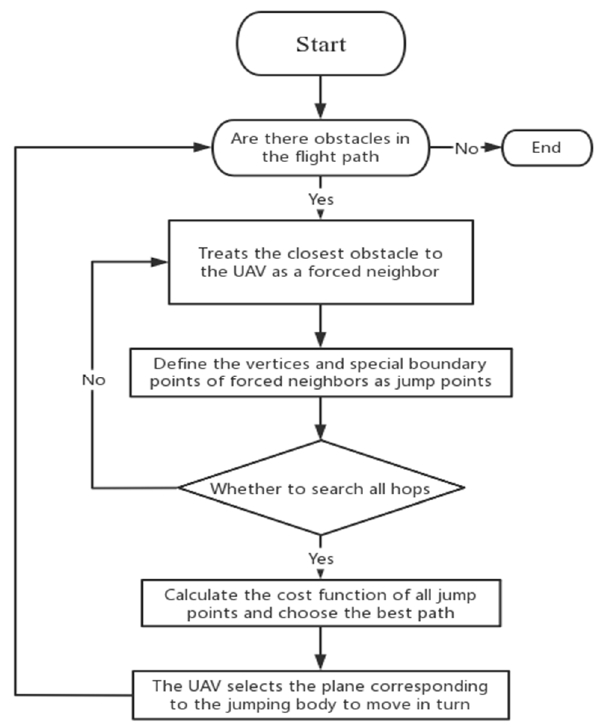
Figure 6. Work flow diagram of RJA star algorithm.